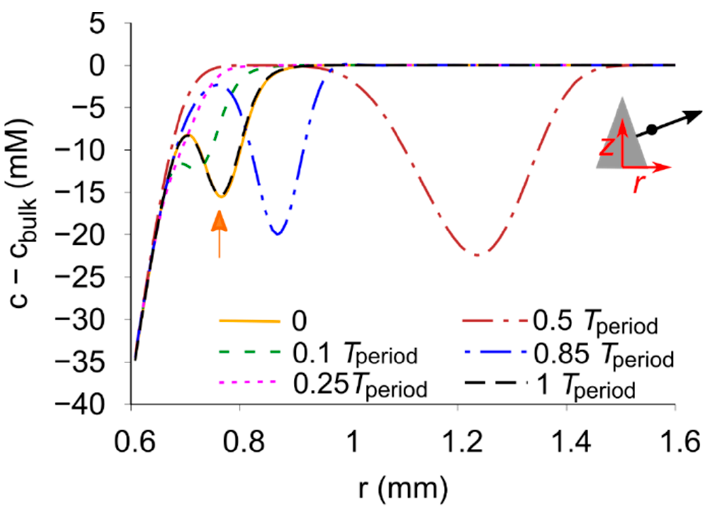
Figure 10. Concentration variation at the electrode-normal monitoring line passing the lower mon- itoring point (0.77, 1.02) mm for selected points in time within one oscillation period. The bulk concentration of CuSO 4 is 300 mM, J = 8 mA/cm 2 . The horizontal axis r represents the radial coordi- nate of the cylindrical coordinate system which originates at the bottom center of the cone. The black arrow shows the position of the monitoring line and the orange arrow shows the radial position of the monitoring point.